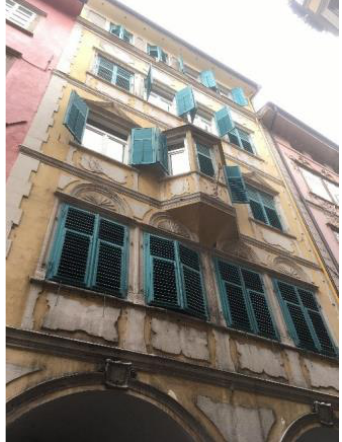
Figure 14. Wooden shutters with orientable slats in Bolzano.